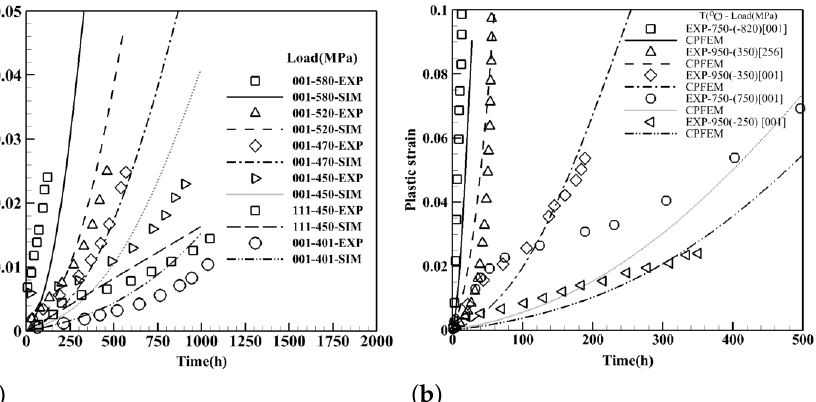
Figure 9. Creep curves for single crystals of CMSX-4 identifying the orientation dependence of the model in tension and compression loading conditions along with the comparison to the experimental data for ( a ) low to medium [36] and ( b ) medium to high load intensities